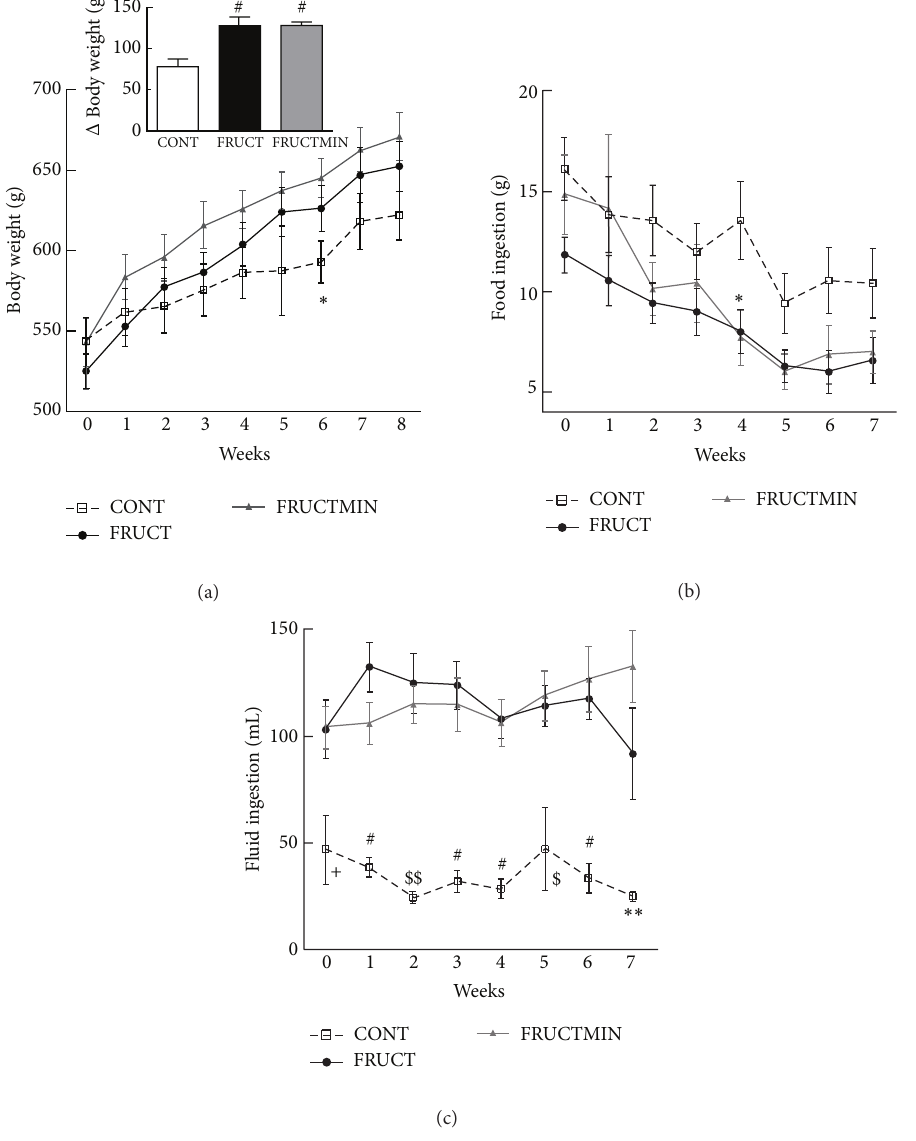
Figure 1: (a) Body weight (g; 𝑛 = 7 ; ∗ 𝑃 < 0.05 CONT versus FRUCTMIN ( Δ body weight (g; 𝑛 = 7 ), between weeks 8 and 0 in the inset; # 𝑃 < 0.01 FRUCT and FRUCTMIN versus CONT)), (b) food ingestion (g; 𝑛 = 7 ; ∗ 𝑃 < 0.05 CONT versus FRUCTMIN, and (c) fluid ingestion evolution (mL; 𝑛 = 7 ; + 𝑃 < 0.05 CONT versus FRUCT and FRUCTMIN; # 𝑃 < 0.001 CONT versus FRUCT and FRUCTMIN; $ 𝑃 < 0.05 CONT versus FRUCT and 𝑃 < 0.01 CONT versus FRUCTMIN; $$ 𝑃 < 0.01 CONT versus FRUCT and 𝑃 < 0.05 CONT versus FRUCTMIN; ∗∗ 𝑃 < 0.01 CONT versus FRUCTMIN), during the dietary intervention. Results were expressed as mean ± standard error of the mean. CONT: control; FRUCT: 10% fructose in tap water; FRUCTMIN: 10% fructose in natural mineral-rich water.